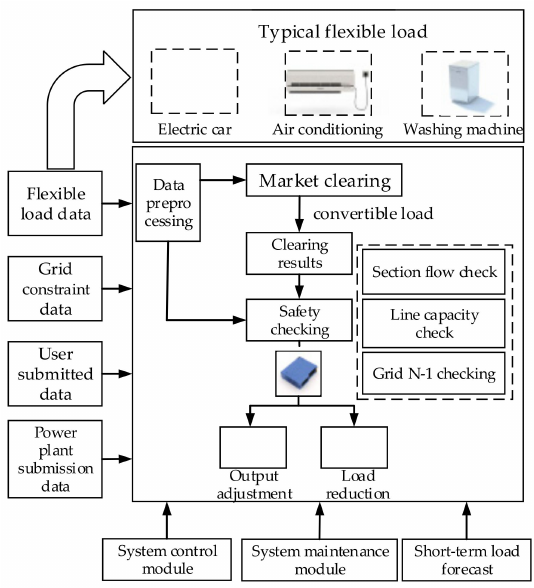
Figure 3. Market clearing and safety checking framework that considers the flexible load.